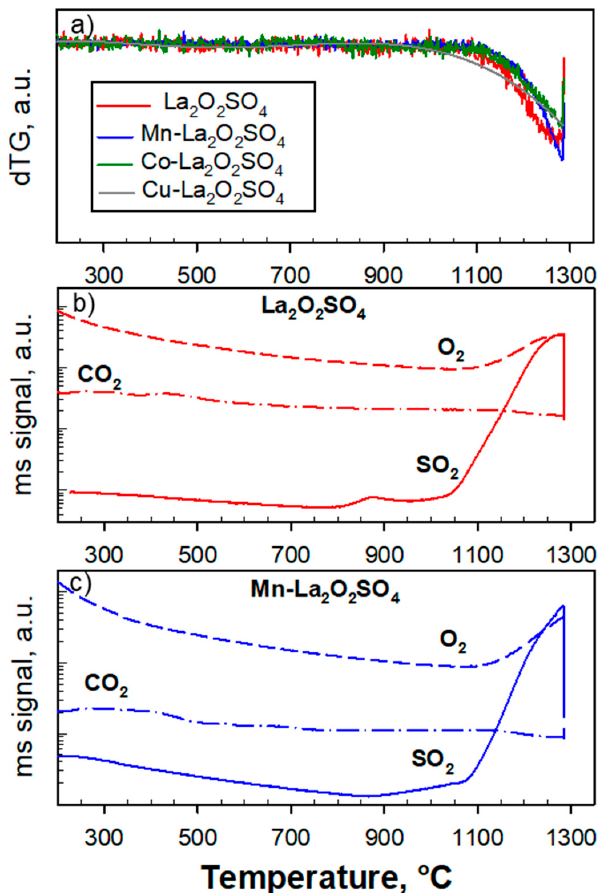
Figure 2. ( a ) dTG curves for La 2 O 2 SO 4 and metal (Cu, Mn, Co) promoted La 2 O 2 SO 4 during heating under a N 2 flow. Heating rate: 10 °C min − 1 . Corresponding MS temporal profiles for O 2 ( m/z = 32), CO 2 ( m/z = 44), and SO 2 ( m/z = 64) concentration in the evolved gas relevant to ( b ) La 2 O 2 SO 4 and ( c ) Mn-La 2 O 2 SO 4 .